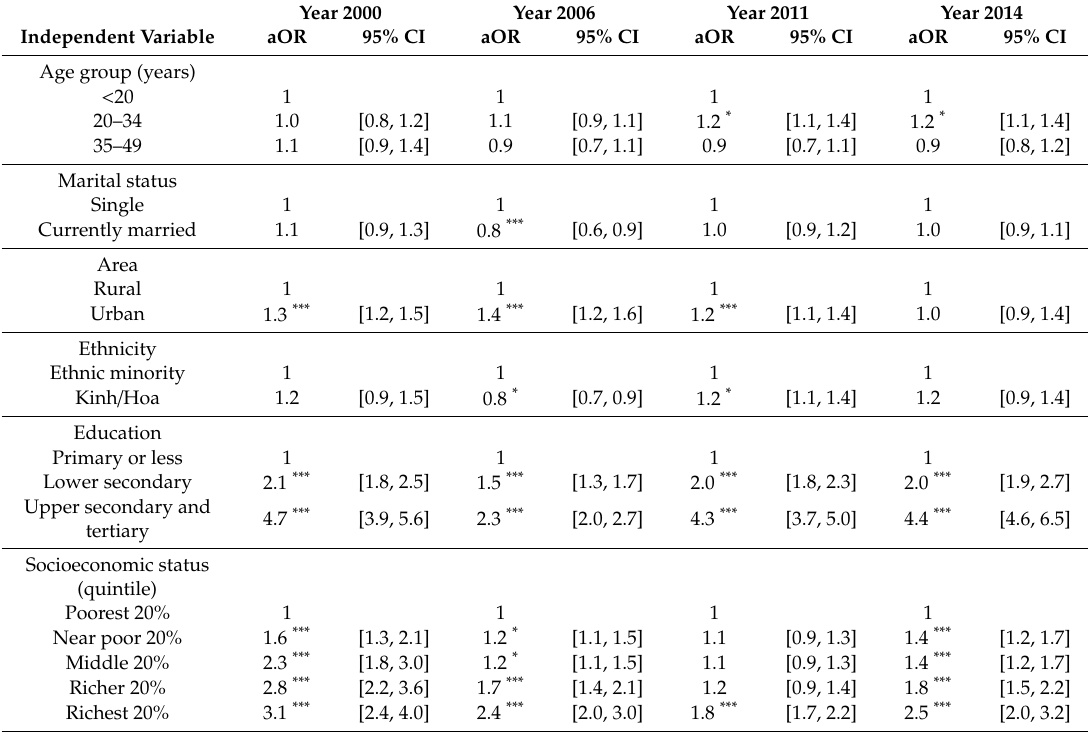
Table 3. Factors associated with comprehensive knowledge about HIV among women aged 15–49 years, 2000–2014: multivariate logistic regression